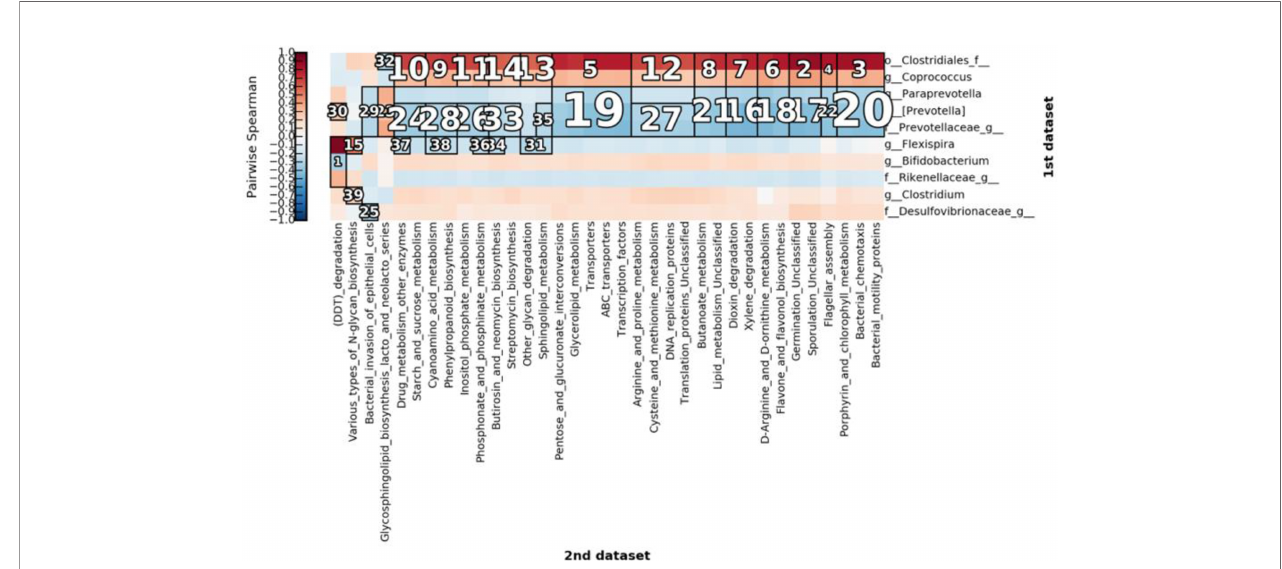
FIGURE 12 | Clustering for correlation clustering analysis by HAllA. The fi gure highlights the correlation between clusters after clustering. The number marked in the fi gure is the ranking of the correlation of corresponding clusters. The smaller the number, the higher the correlation. The differential bacteria are shown on the right and metabolic pathways are shown